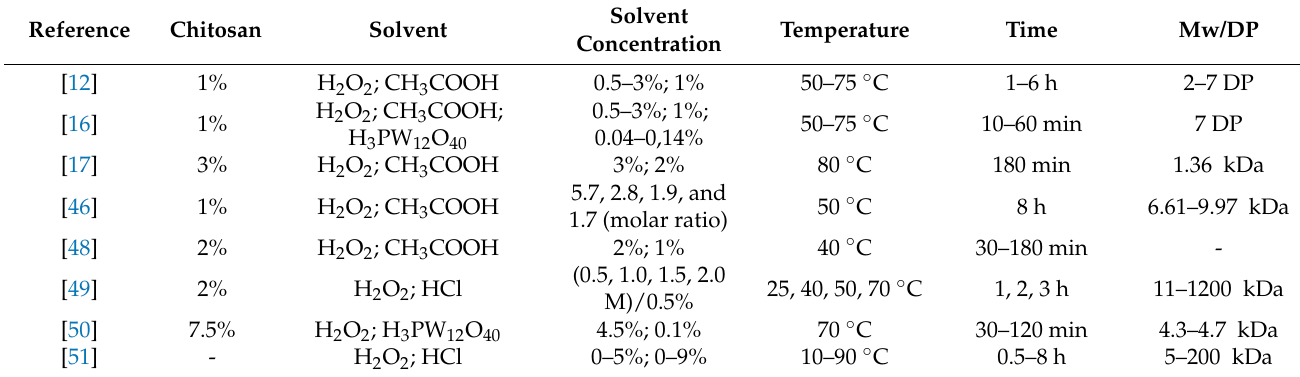
Table 4. Parameters of chitosan hydrolysis by hydrogen